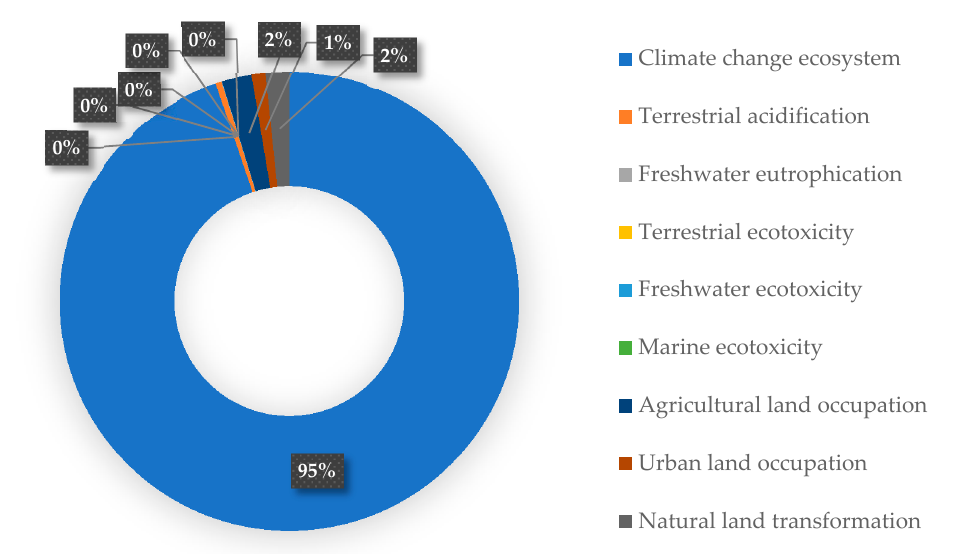
Figure 10. Contribution of each impact category to the total ecosystem damage (species.yr) of 1 kg of SPF-reinforced sago starch composite takeout food container.